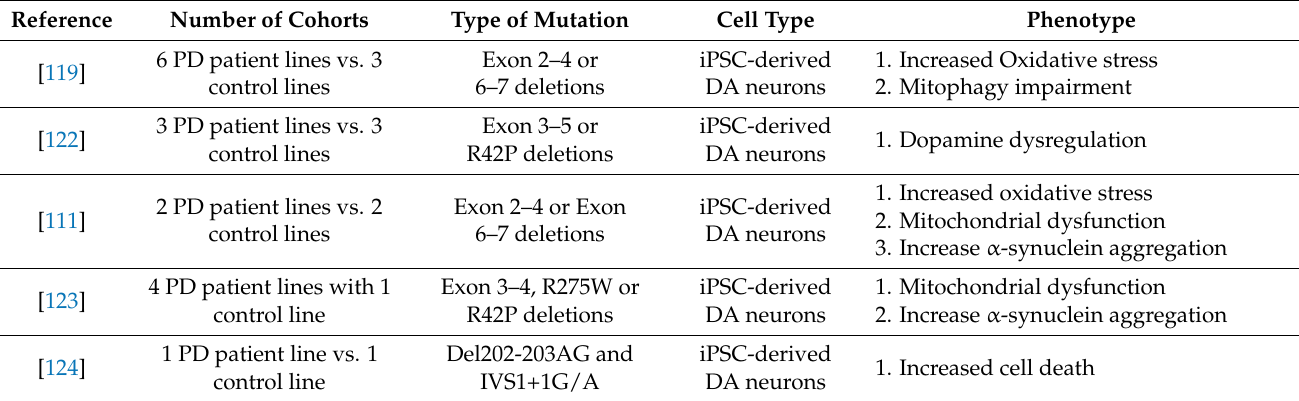
Figure 3. Effect of PINK1 and parkin mutation in IPSC-derived neurons. Parkin mutation in iPSC- derived neurons showed impairment in their requitement to PINK1 , alteration in spontaneous postsynaptic current activity, reduction in dopamine receptor and release. PINK1 mutation in iPSC-derived neurons displayed fragmented mitochondria with alteration their DNA level, ATP, membrane potential and oxidative stress. Additionally, there is an increase in apoptotic cell death and α -synuclein aggregation and accumulation. Table 3. PARK2-mutated iPSC-derived neuronal